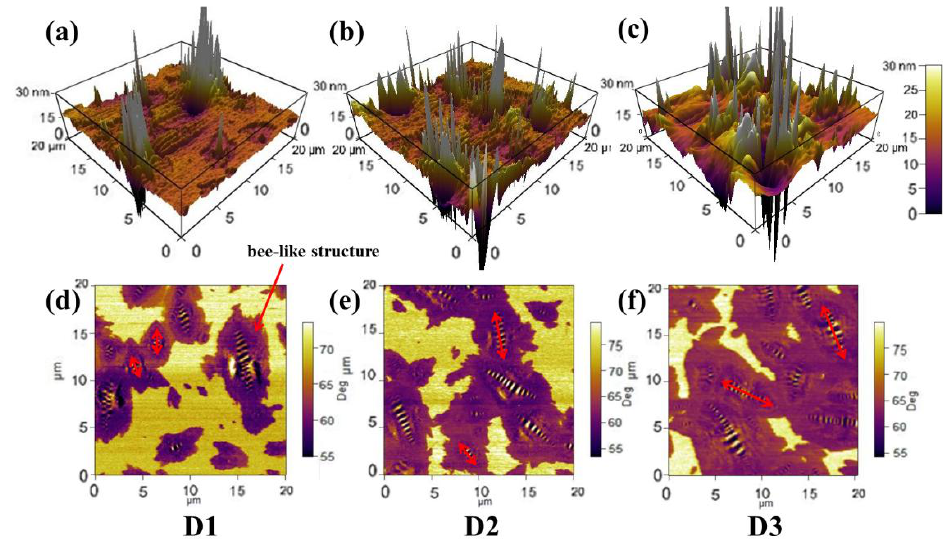
Figure 5. AFM images for the CR rejuvenated sample: (a) 3D height images of D1 slices; (b) 3D height images of D2 slices; (c) 3D height images of D3 slices; (d) phase images of D1 slices; (e) phase images of D2 slices; (f) phase images of D3 slices.